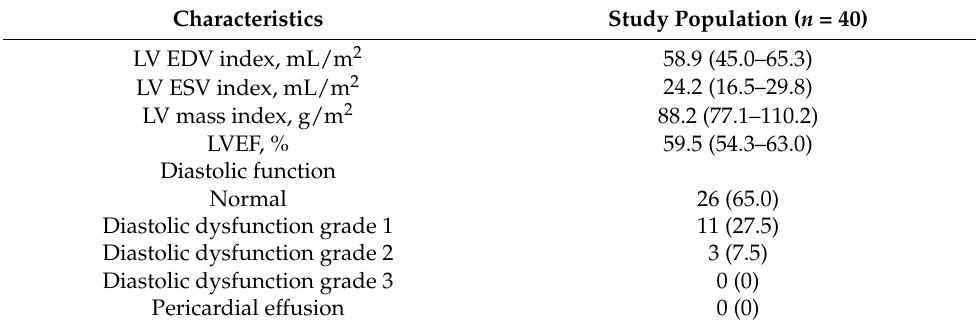
Table 2. Echocardiographic analysis.